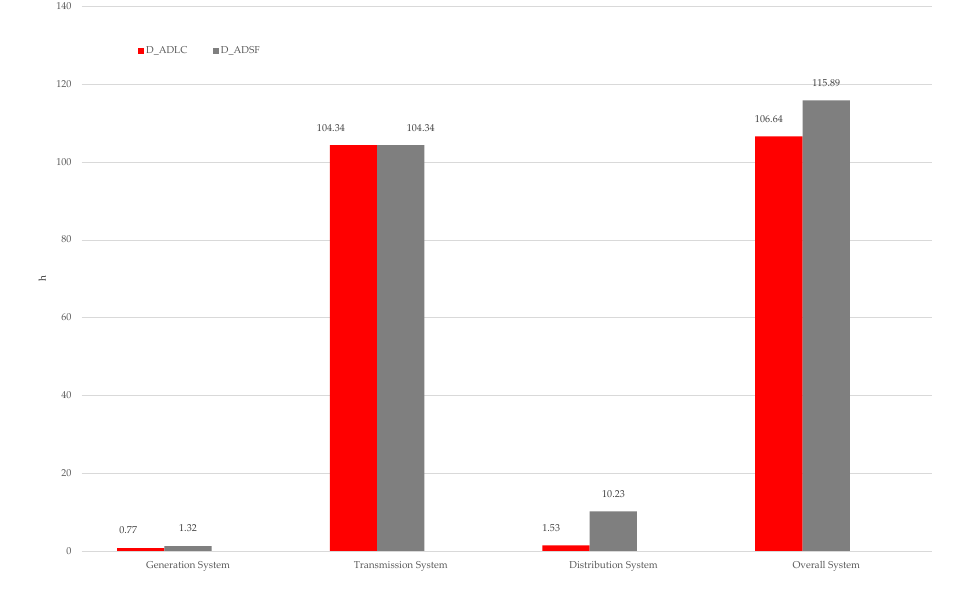
Figure 9. Comparison of subsystem duration indicators.